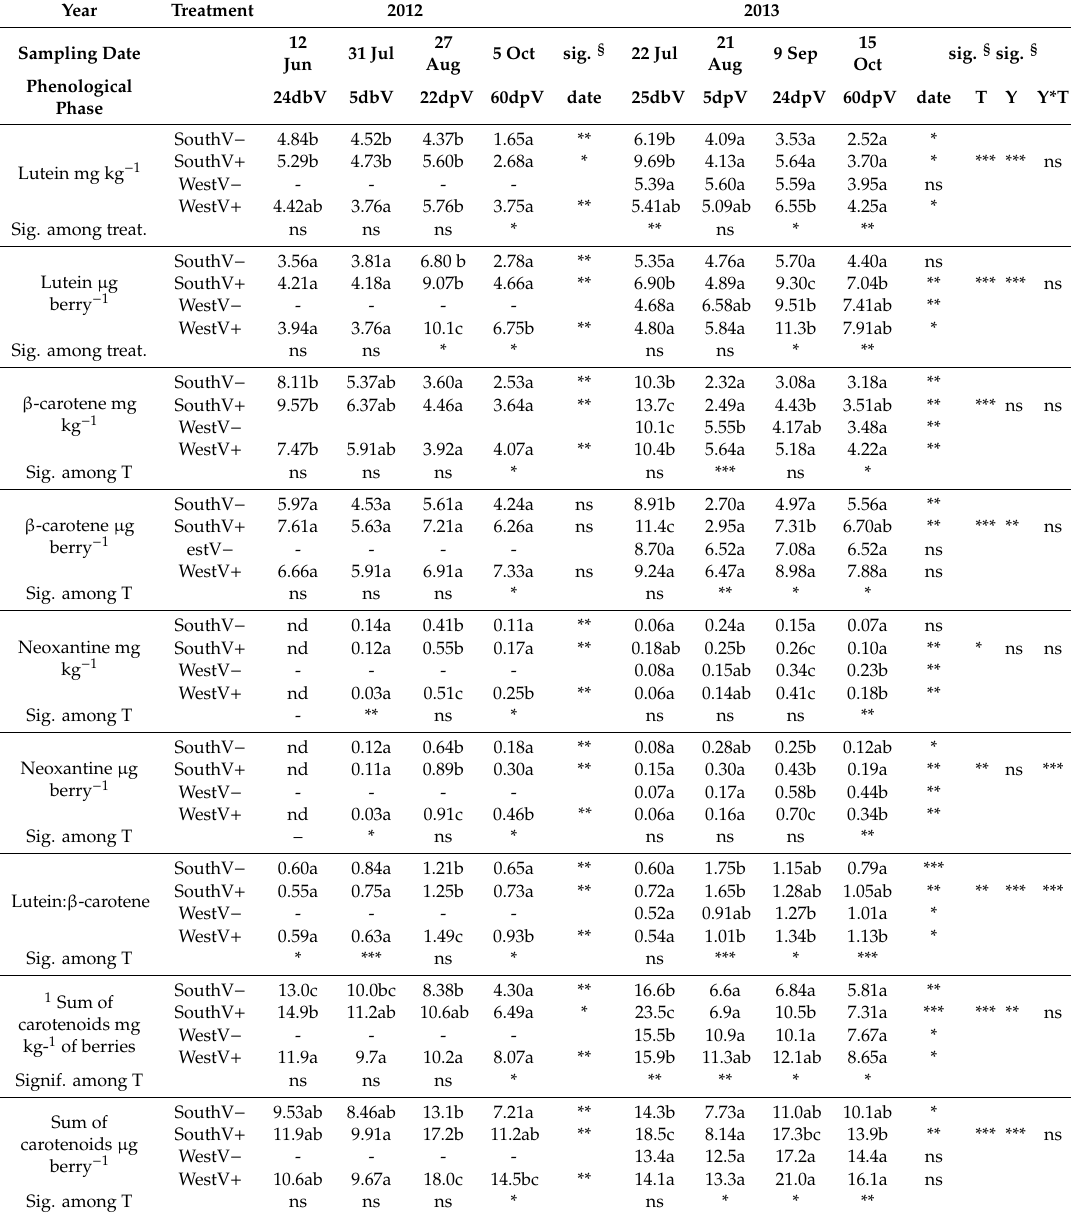
Table 4. Seasonal changes of the carotenoid concentration and of the ratio Lutein: β -carotene in Nebbiolo grapes during 2012 and